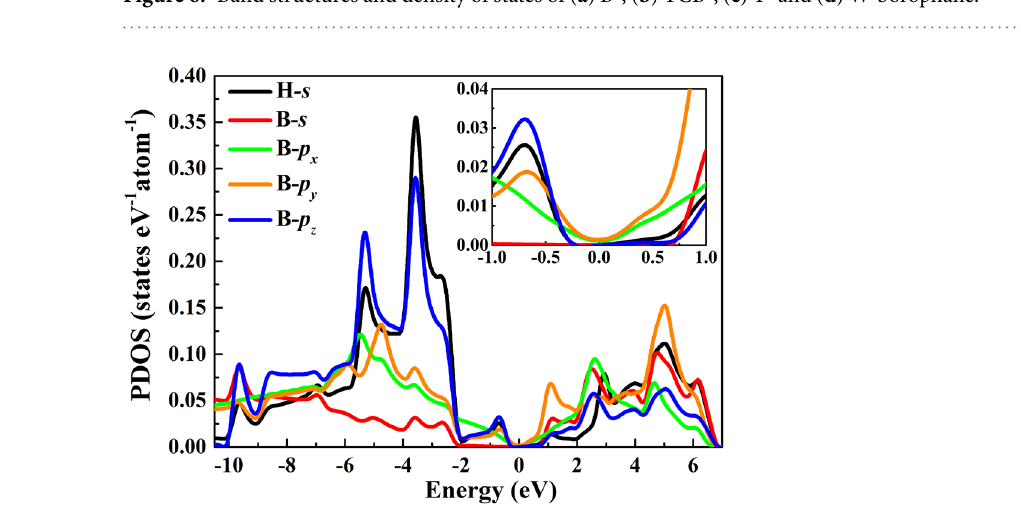
Figure 6. Band structures and density of states of ( a ) B-, ( b ) TCB-, ( c ) T- and ( d ) W-borophane.